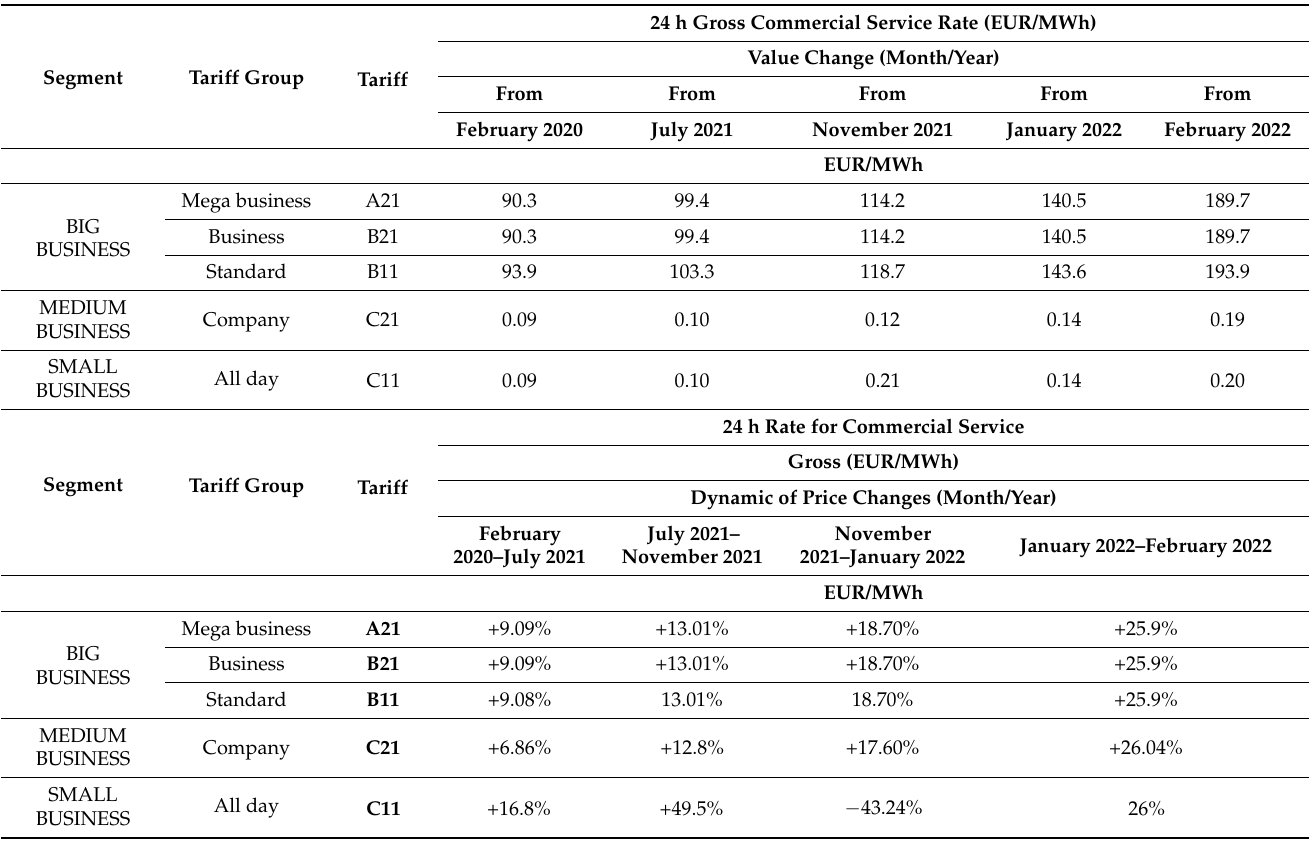
Table 2. Electricity price increases for end consumers of the leading electricity operator in Poland,